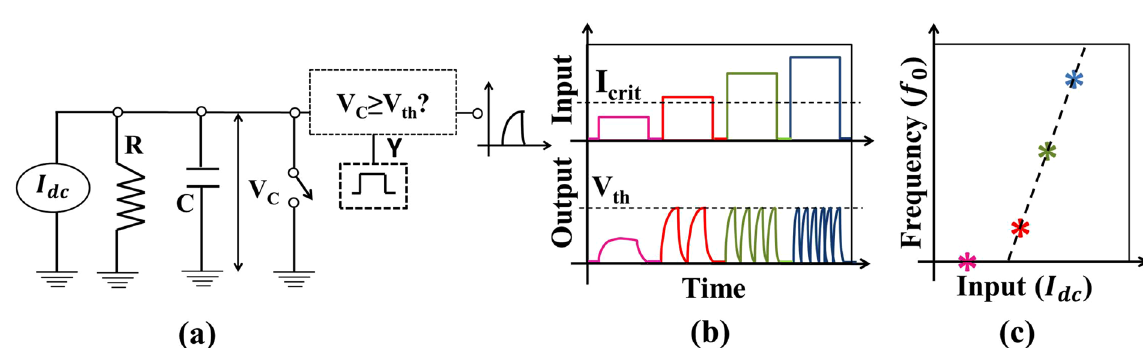
Figure 2. ( a ) LIF neuron circuit model, ( b ) For input (I dc < I crit ), V(t) never exceeds V th - hence neuron never spikes. However, for I dc ≥ I crit , neuron will fire when V(t) ≥ V th and immediately reset i.e. V(t) = E L , ( c ) With higher input (e.g. I dc ≥ I crit ), firing rate or the frequency increases like a biological neuron while for low input (I dc < I crit ), frequency is zero. The output frequency (f o ) vs. input is the signature neuronal function to be mimicked